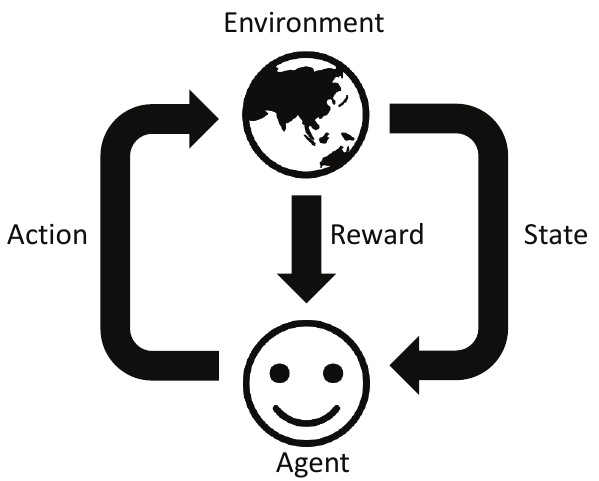
Figure 2. Conceptual architecture of reinforcement learning